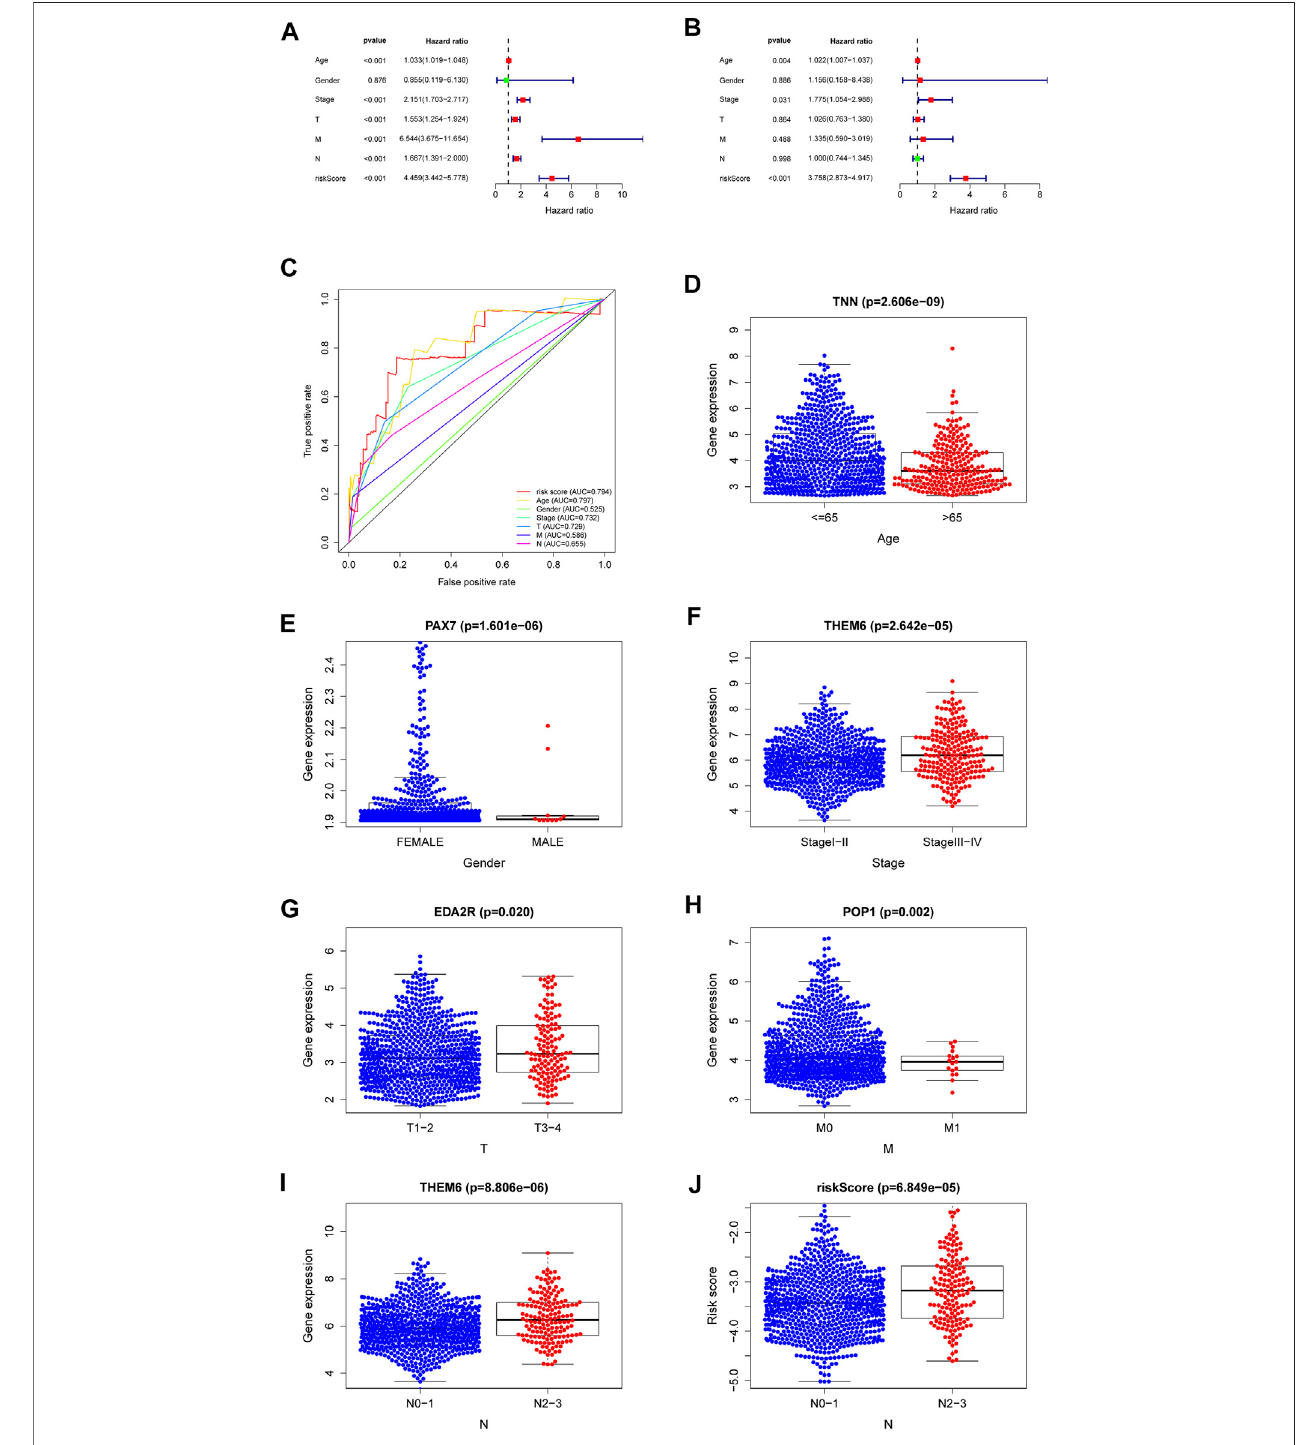
FIGURE 5 | A forest plot of univariate Cox regression analysis in the cohorts (A) . A forest plot of multivariate Cox regression analysis in the cohorts (B) . The ROC analysis of OS for the signature and the clinicopathologic parameters (C) . Necroptosis-related-gene TNN in the cohorts strati fi ed by age (D) . Necroptosis-related-gene PAX7 in the cohorts strati fi ed by gender (E) . Necroptosis-related-gene THEM6 in the cohorts strati fi ed by stage (F) . Necroptosis-related-gene EDA2R in the cohorts strati fi ed by T stage (G) . Necroptosis-related-gene POP1 in the cohorts strati fi ed by M stage (H) . Necroptosis-related-gene THEM6 in the cohorts strati fi ed by N stage (I) . The necroptosis-related signature in the cohorts strati fi ed by N stage (J) .